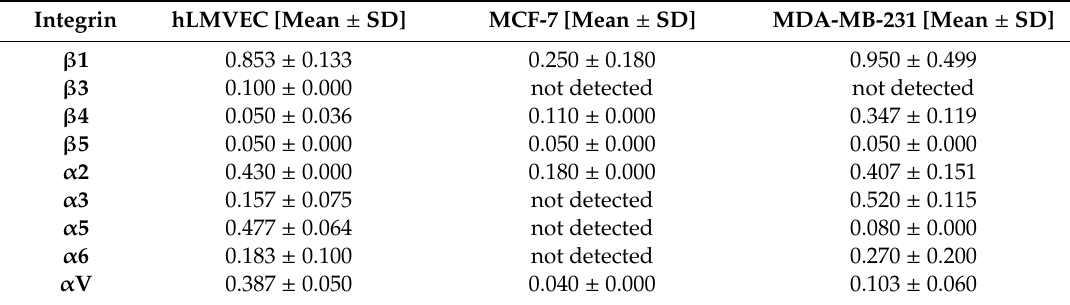
Table 4. Content of integrins in hLMVEC, MCF-7 and MDA-MB-231 cell